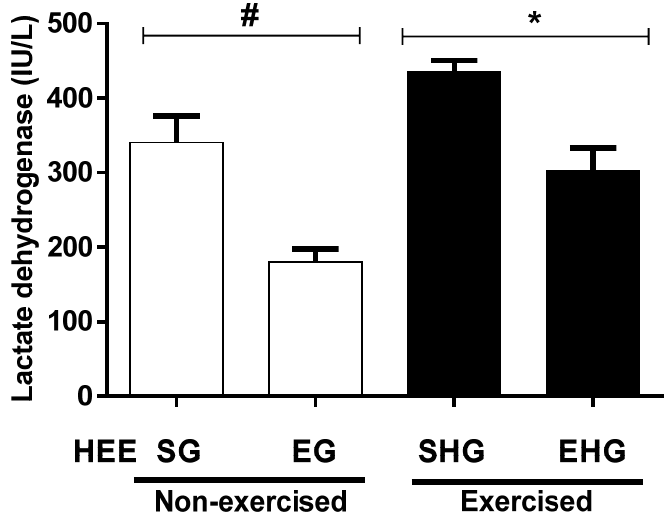
Figure 6. Evaluation of lactate dehydrogenase (LDH) plasma in animals subjected to the administration of hydroethanolic extract of C. argyrophyllus (HEE) and further execution of acute resistance exercise. The results are presented as mean ± SEM and evaluated by one-way ANOVA with a Bonferroni post test; p < 0.05. # SG—sedentary vehicle group; EG—exercise vehicle group; SHG—sedentary group HEE; EHG—HEE exercise group.